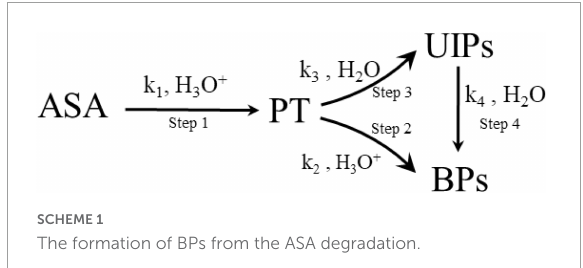
SCHEME1 The formation of BPs from the ASA